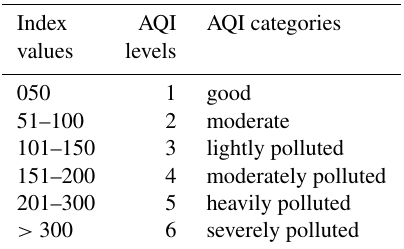
Table 1. Chinese AQI categories. Table 2. Individual AQI (IAQI) for 1 and 8h ozone, 24 and 1h NO 2 , and 24h PM 2 . 5